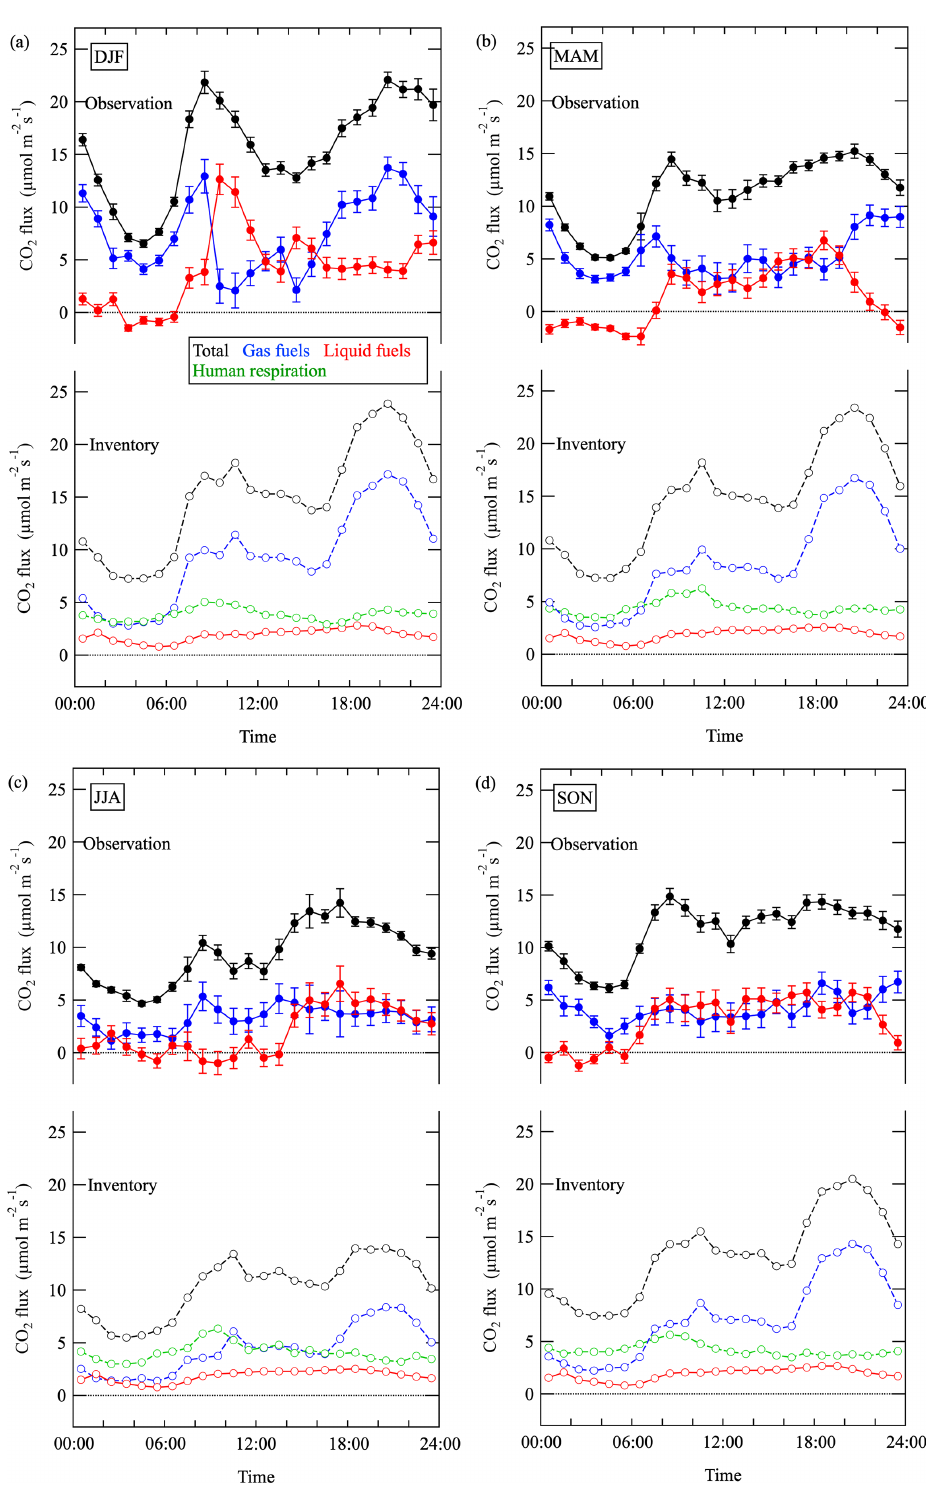
Figure 9. Average diurnal cycles of the total CO 2 flux observed using the eddy correlation method (black filled circles) and the estimated CO 2 flux from gas (blue filled circles) and liquid (red filled circles) fuel consumption by using the total CO 2 flux and OR F for each season: December to February (a) , March to May (b) , June to August (c) and September to November (d) . Average diurnal cycles of the CO 2 emission inventory of gas consumption (blue open circles), traffic (red open circles), human respiration (green open circles) and their total (black open circles) around YYG are also shown for each season. See text in